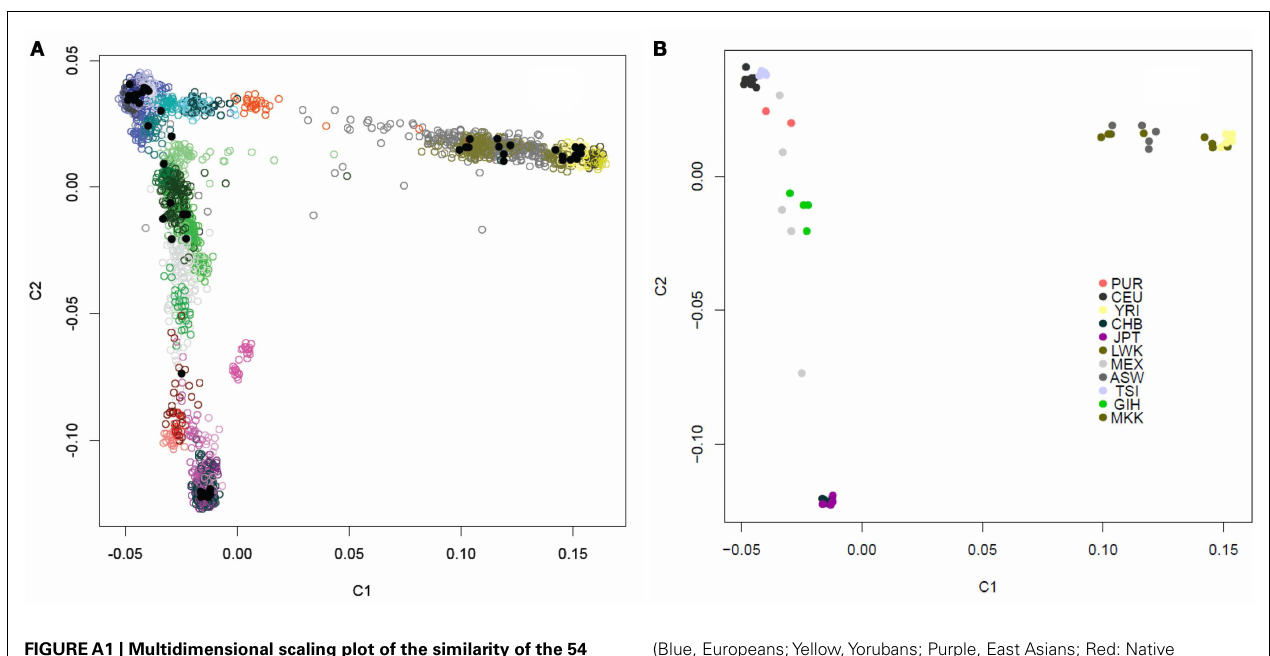
FIGUREA1 | Multidimensional scaling plot of the similarity of the 54 unrelated individuals with complete genome data. (A) The 54 individuals (black dots) overlaid on 4,123 individuals of known ancestry based on 16,411 ancestry informative markers.The individuals with known ancestries were obtained from public repositories and are color coded by continent with shading indicating subpopulations within those continents